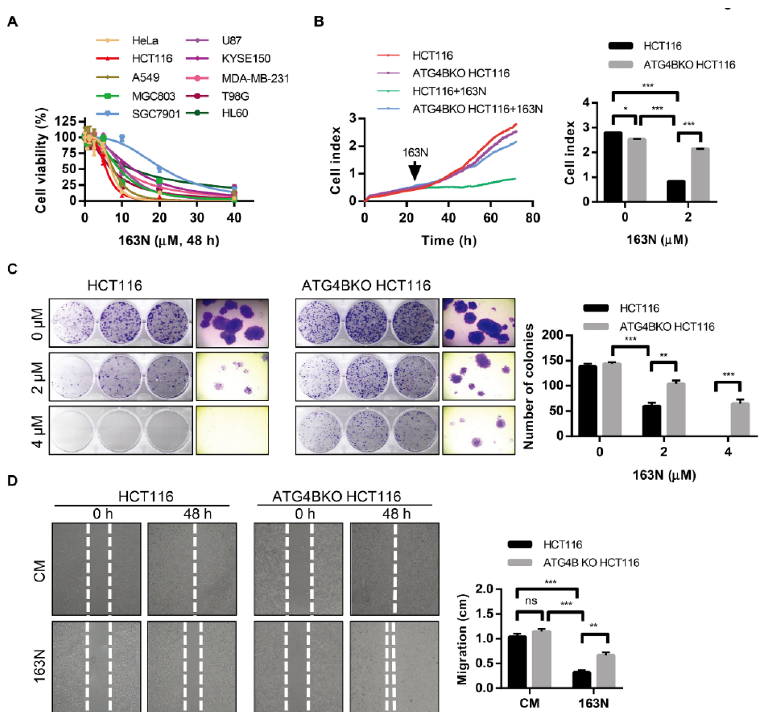
Figure 6. 163N suppresses the growth of colorectal cancer cells in vitro. ( A ) HeLa, HCT116, A549, MGC803, SGC7901, U87, KYSE150, MDA-MB-231, T98G, and HL60 cells were treated with various concentrations of 163N, and CCK-8 assay was performed to assess cell proliferation. ( B ) HCT116 and ATG4BKO HCT116 cells (2500 per well) were seeded before treated with 163N (2 µM), and 0.1% Dimethyl-sulfoxide (DMSO) was used as a control. The real-time cellular analysis (RTCA) plots were generated using RTCA software 1.1.2, and the cell index was analyzed with GraphPad 7.0 software. ( C ) HCT116 and ATG4BKO HCT116 cells were treated with a series of concentrations of 163N. Colony formation assay was then monitored by crystal violet staining. The number of the clones were counted and quantified. ( D ) HCT116 and ATG4BKO HCT116 cells were treated with or without 163N (10 µM) for 48 h, wound healing was recorded (left) and quantitatively analyzed (right). Data are presented as mean ± SEM from three individual experiments. * p < 0.05, ** p < 0.01, *** p < 0.001.